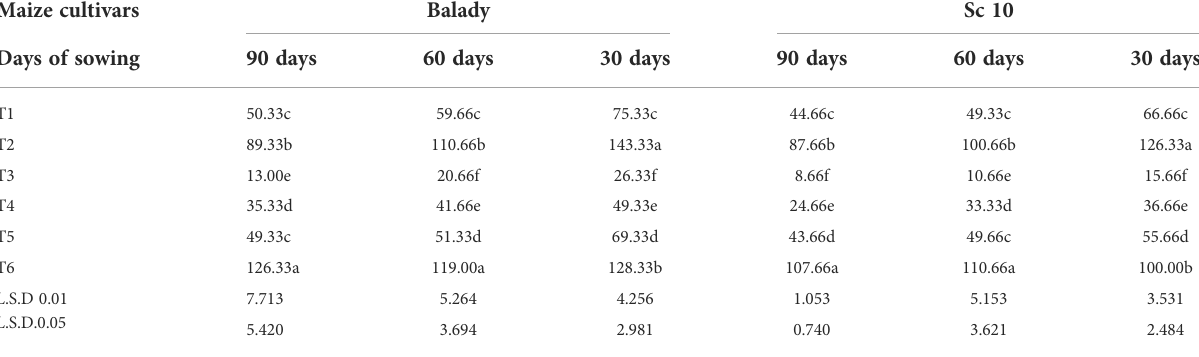
TABLE 3 Fusarium verticillioides frequency from soil under different treatments at different times after sowing during the 2021 growing season. Maize cultivars Balady Sc 10 Days of